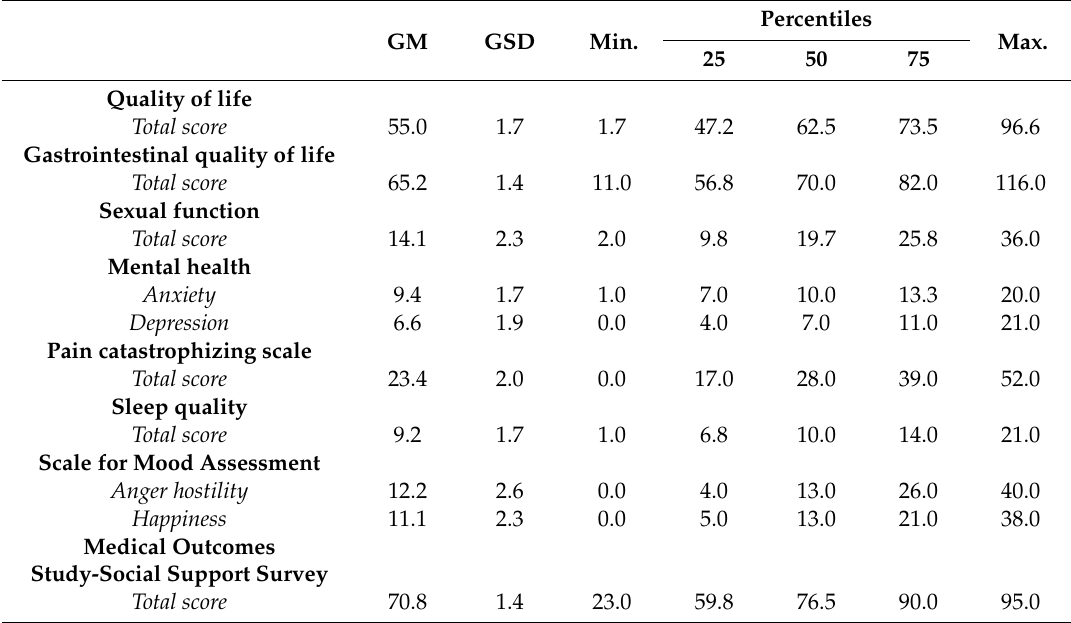
Table 3. Psychosocial status and quality of life in women with